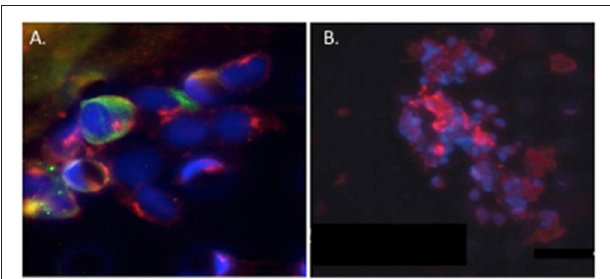
FIGURE 4 | Circulating cCAF/circulating tumor cell (CTC) clusters and cCAF clusters in breast cancer patient blood. (A) cCAF/CTC co-cluster and (B) cCAF cluster. Red: FAP, Green: CK. From Ao et al.